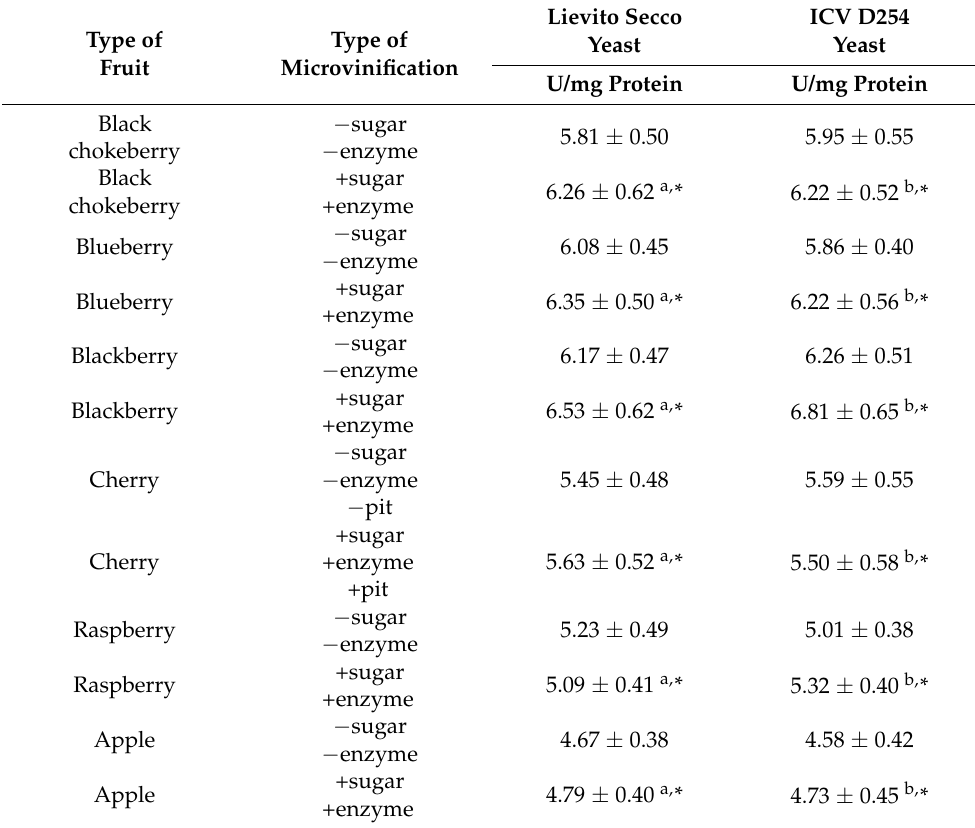
Table 1. The specific activities of SOD (U/mg protein) obtained for wine-treated synaptosomes with H 2 O 2 -induced oxidative stress for different types of fruit wines and